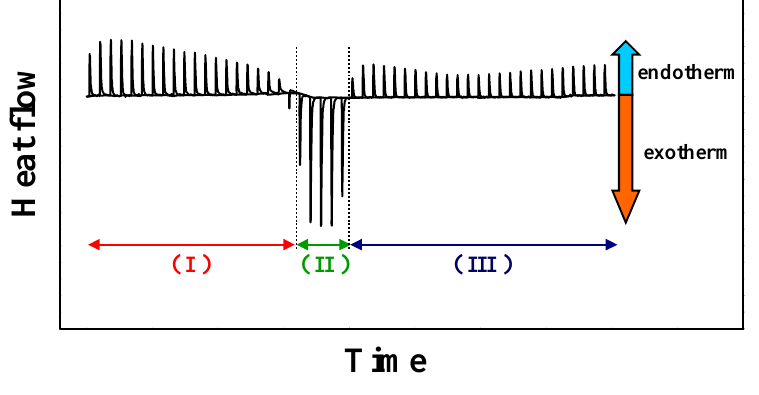
Figure 5 . Schematic representation of a solubilisation experiment representing the titration of a micellar detergent solution into a liposomal dispersion. The experimental conditions